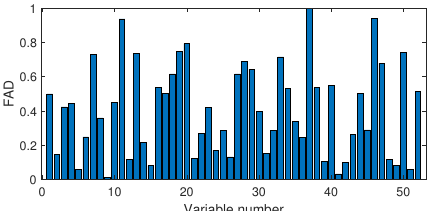
Figure 12. Fault isolation results for fault F10 based on Pearson